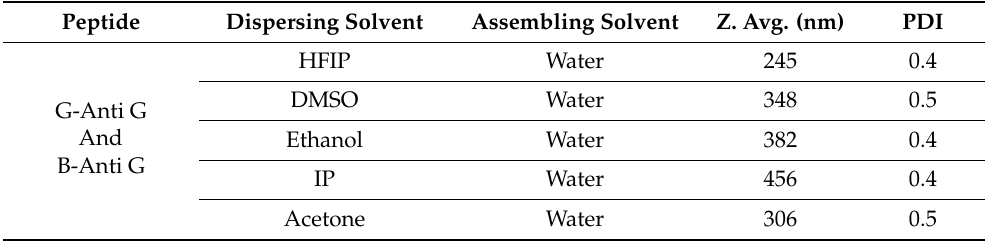
Table 1. The results revealed the formation of nanostructures with a diameter of 245 nm (PDI: 0.4) in HFIP, 348 nm (PDI: 0.5) in DMSO, 382 nm (PDI: 0.4) in ethanol, 456 nm (0.4) in IP, and 306 nm (PDI: 0.5) in acetone, and they demonstrated that the overall size and the